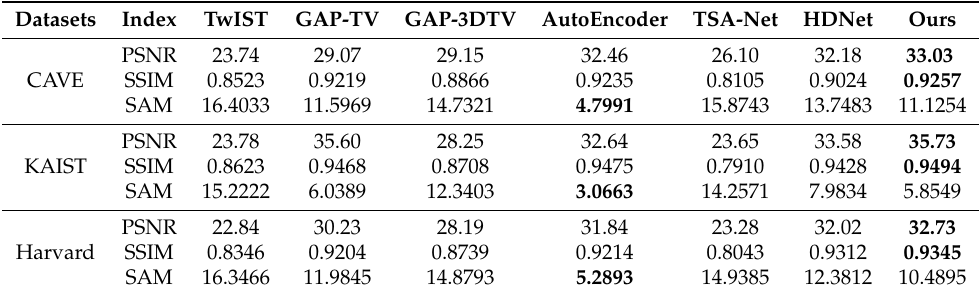
Table 1. Average PSNR and SSIM comparison of competing methods on the CAVE, KAIST, and Harvard datasets.